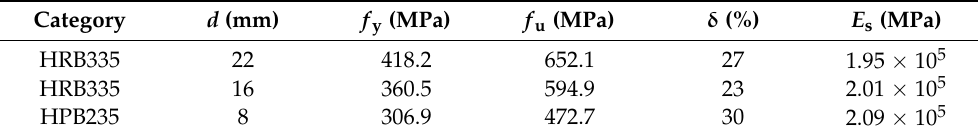
Table 1. Mechanical properties of reinforcing bars.